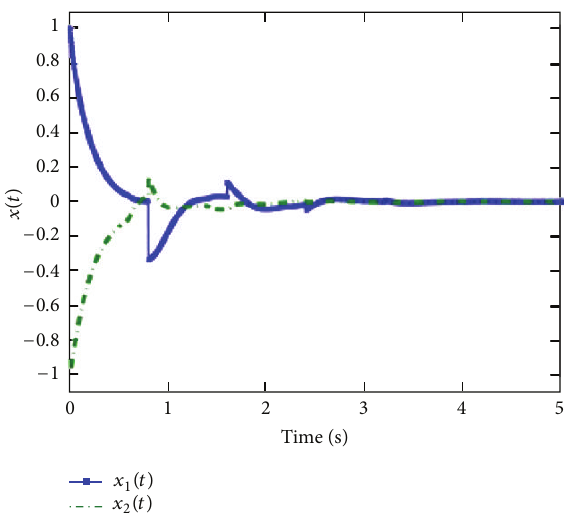
Figure 1: The simulation of the solutions 𝑥 1 (𝑘) and 𝑥 2 (𝑘) with the initial condition 𝜙(𝑘) = [10 5] 𝑇 , 𝑘 ∈ [0, 10] .